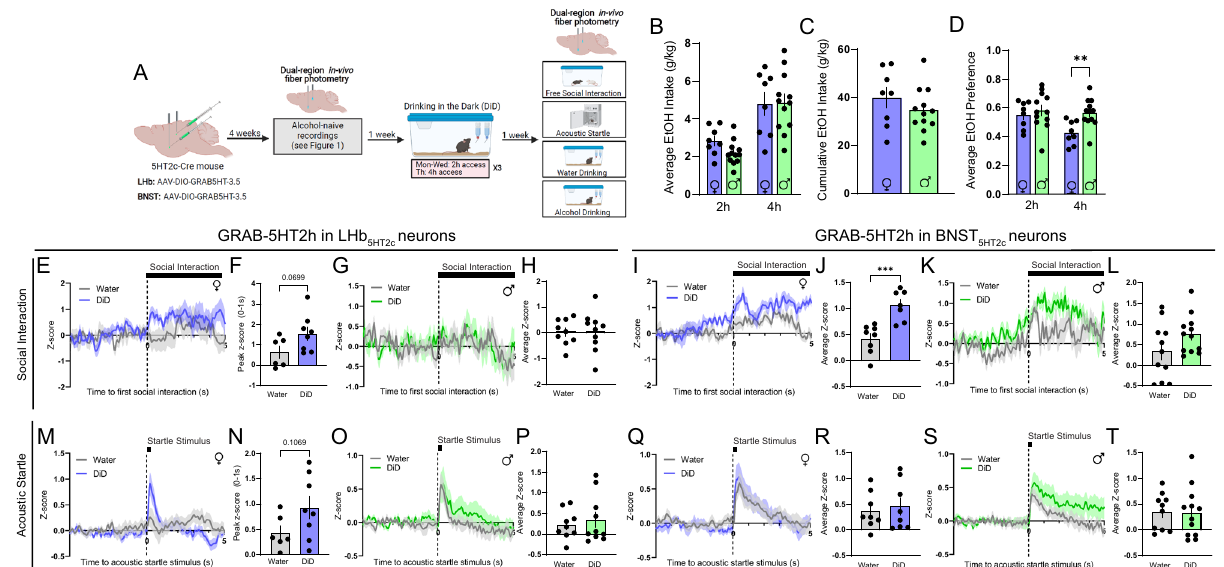
Fig.8|DiDmodulatesserotoninreleaseontoLHb 5HT2c andBNST 5HT2c neurons signal for 0 – 5s post interaction, males (water n =11 mice/1 trial, DiD n =12 mice/1 during exposure to affective stimuli. A Surgical schematic and experimental trial). M Peri-event plot of LHb 5HT2c GRAB-5HT activity during the acoustic startle timeline for LHb 5HT2c and BNST 5HT2c GRAB-5HT fi ber photometry experiments in test, females(water n =6 mice/10trials, DiD n =8mice/10trials). N Peakz-scoreof DiD-exposed mice. B Average alcohol consumption in DiD, p 2h =0.0532 (Females LHb 5HT2c GRAB-5HT signal for 0 – 1s post acoustic startle stimulus, females (water n =8 mice, Males n =12 mice). C Cumulative alcohol intake in DiD, p =0.2897 n =6 mice/10 trials, DiD n =8 mice/10 trials). O Peri-event plot of LHb 5HT2c GRAB- 5HT activity during the acoustic startle test, males (water n =9 mice/10 trials, DiD (Females n =8 mice, Males n =12 mice). D Average alcohol preference in DiD n =10mice/10trials). P Averagez-scoreofLHb n =8 mice, Males n =12 mice). E Peri-event plot of LHb – 5spost p 4h =0.0039 (Females 5HT2c 5HT2c GRAB-5HTsignalfor0 GRAB-5HT activity during the fi rst interaction with a novel social target, females, (water n =6mice/1trial,DiD n =8mice/1trial). F Averagez-scoreofLHb 5HT2c GRAB- 5HT signal for 0 – 5s post interaction, females, p =0.0699 (water n =6 mice/1 trial, DiD n =8 mice/1 trial). G Peri-event plot of LHb 5HT2c GRAB-5HT activity during the of BNST 5HT2c GRAB-5HT signal for 0 – 5s post acoustic startle stimulus, females fi rstinteractionwithanovelsocialtarget,males(water n =9mice/1trial,DiD n =10 (water n =8 mice/10 trials, DiD n =8 mice/10 trials). S Peri-event plot of BNST 5HT2c mice/1 trial). H Average z-score of LHb 5HT2c GRAB-5HT signal for 0 – 5s post inter- GRAB-5HT activity during the acoustic startle test, males (water n =11 mice/10 action, males (water n =9 mice/1 trial, DiD n =10 mice/1 trial). I Peri-event plot of BNST 5HT2c GRAB-5HTactivityduringthe fi rstinteractionwithanovelsocialtarget, females (water n =8 mice/1 trial, DiD n =7 mice/1 trial). J Average z-score of BNST 5HT2c GRAB-5HT signal for 0 – 5s post interaction, females, p =0.0008 (water n =8 mice/1 trial, DiD n =7 mice/1 trial). K Peri-event plot of BNST 5HT2c GRAB-5HT activity during the fi rst interaction with a novel social target, males (water n =11 with mice/1 trial, DiD n =12 mice/1 trial). L Average z-score of BNST 5HT2c GRAB-5HT